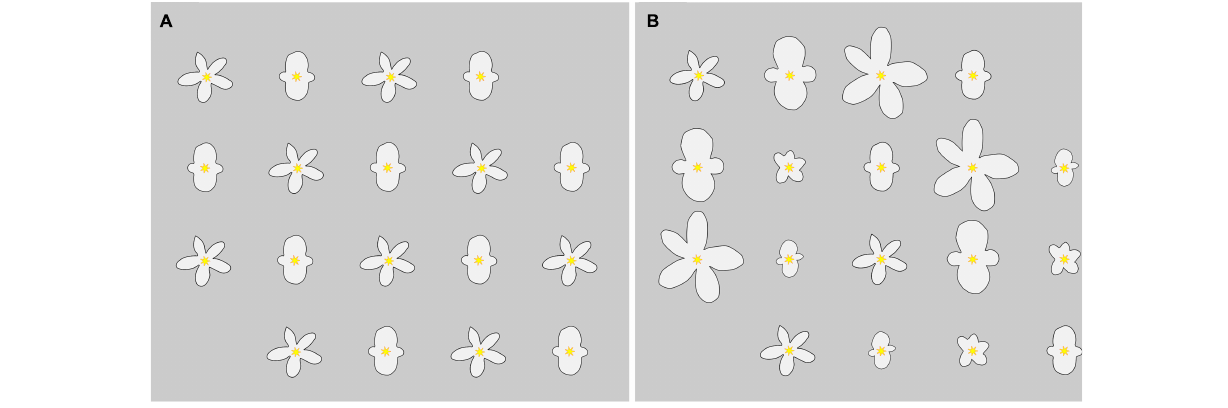
( Figure 5A ; GLMM: treatment effect: χ 2 1 = 1.47, P = 0.226; treatment × experience effect: χ 2 1 = 0.43, P = 0.512) and